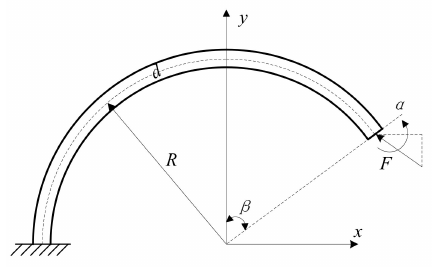
Figure 3. Bending beam model of